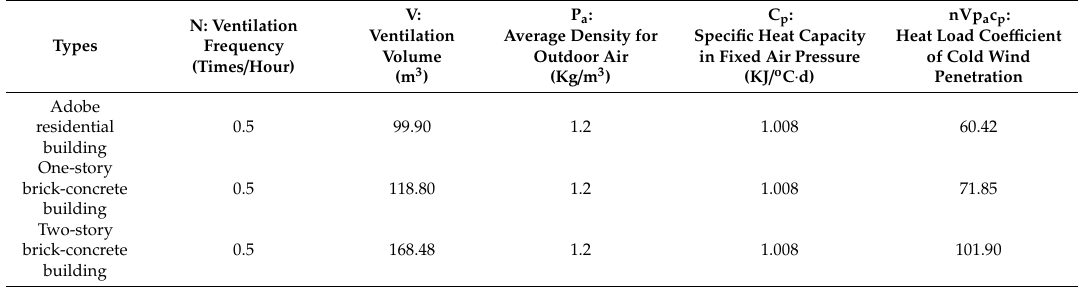
Table 9. The calculation results of the heat load coe ffi cient of cold wind penetration.